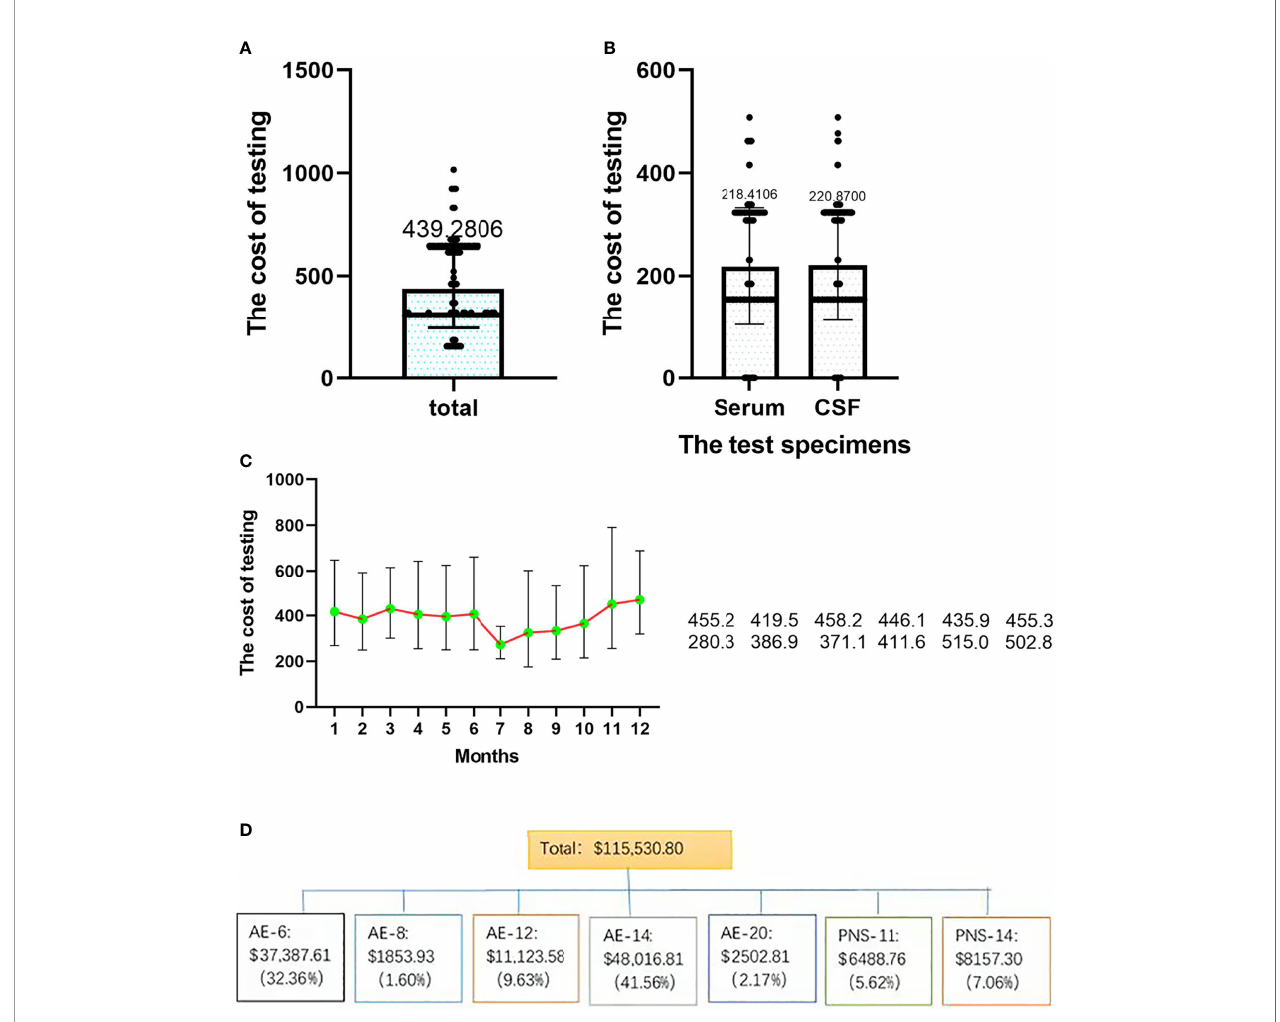
FIGURE 7 | The distributions of testing costs among different samples and seasons. (A) Total testing cost; (B) the costs of different samples; (C) the costs in different seasons. (D) the costs of different test